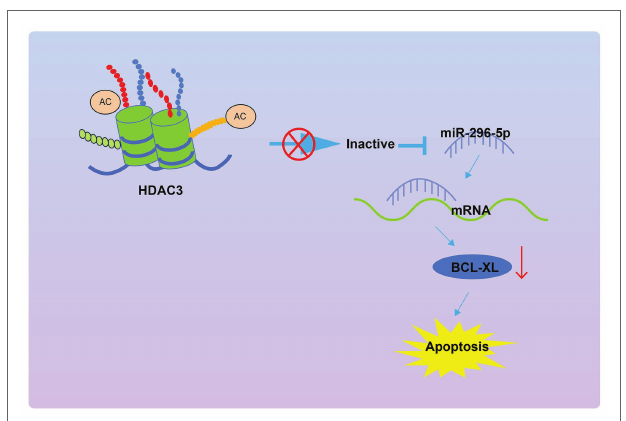
FIGURE 7 | The graphical summary of the function and mechanism of Hdac3 on the apoptosis of PBMCs in T1DM via the miR-296-5p/Bcl-xl